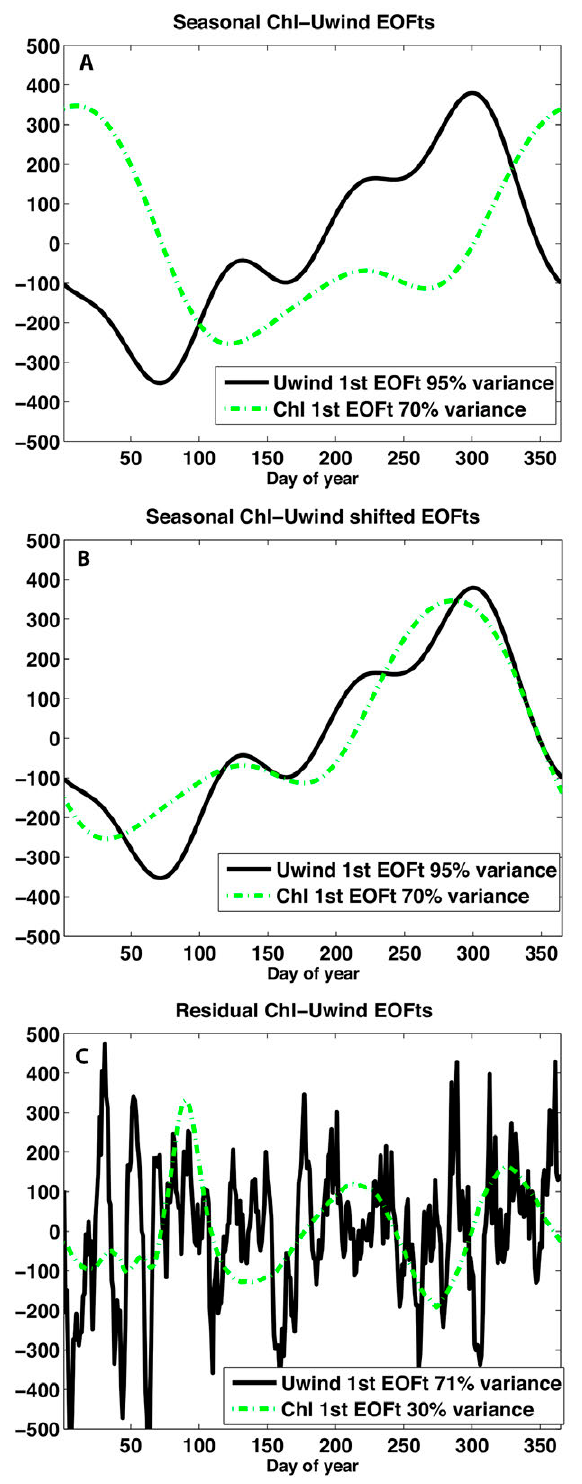
Fig. 3. – A, Chl a and zonal wind seasonal part first EOFts; B, Chl a and zonal wind seasonal part first EOFts with a temporal shift (time lag) of 90 days is applied only in this case; C, Chl a and wind first residual EOFts.